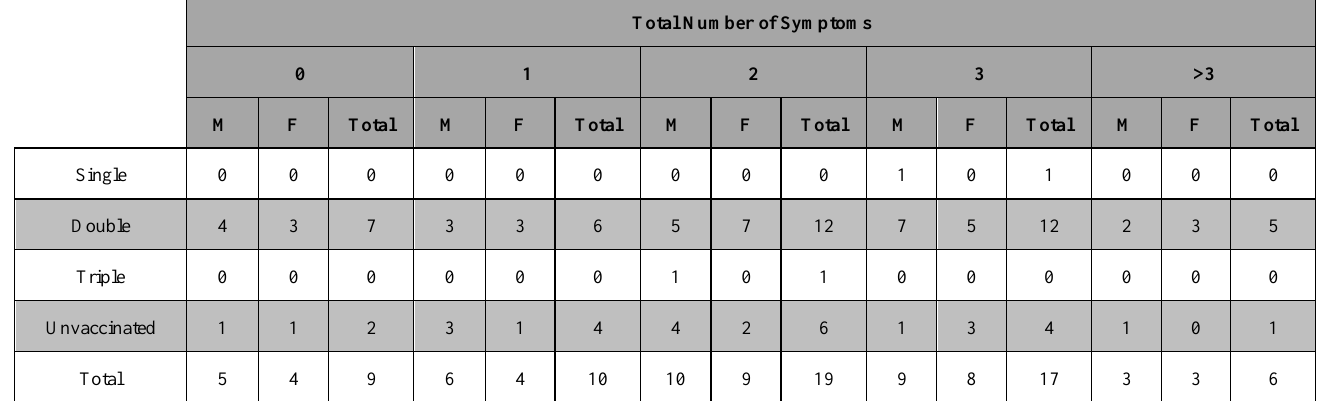
Table 9. A total number of symptoms with respect to vaccination status.